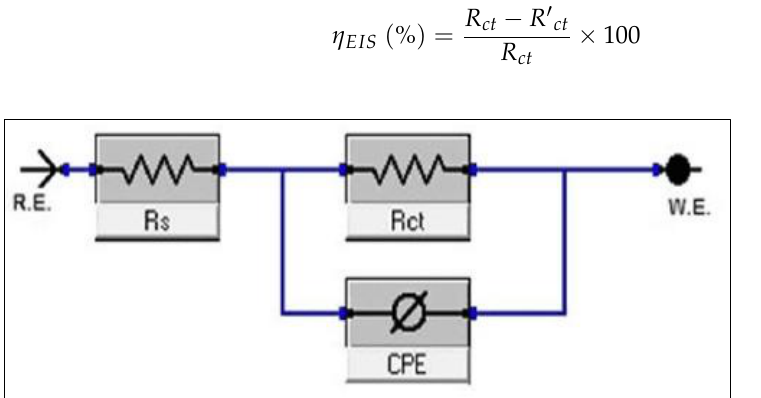
Figure 16. Circuit diagram for EIS experiment. Reprinted from [116].